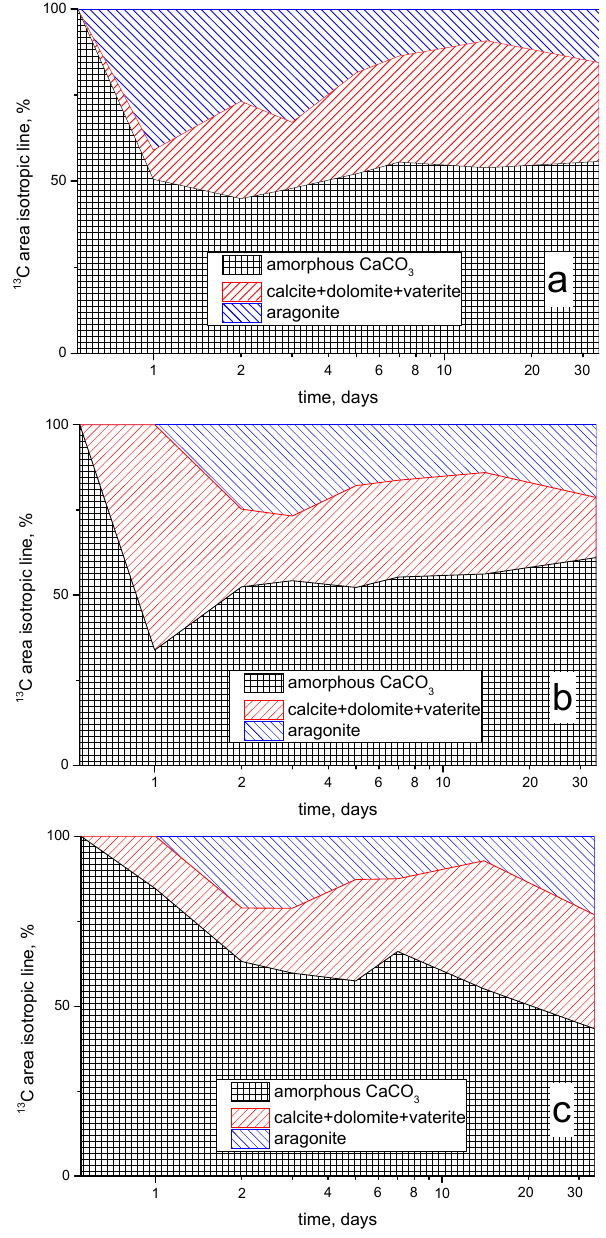
Figure 4. Time-evolution (in logarithmic scale) of the relative integrated areas of the isotropic components recognized in the 13 C NMR spectra of the samples: C ( a ), CAA ( b ) and CSA ( c ).